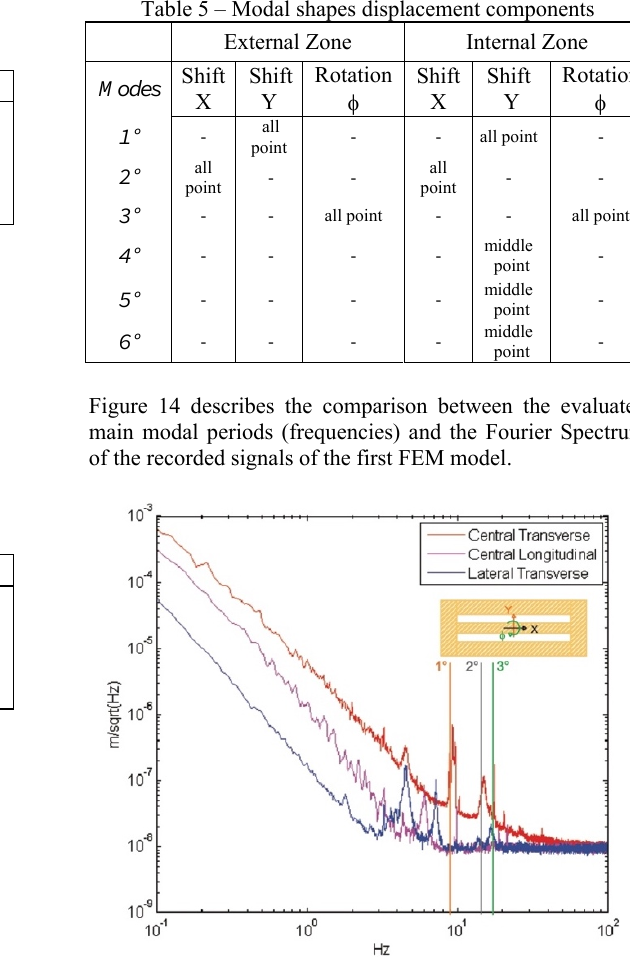
Table 5 describes the activated displacement components in correspondence of the recording stations for each investigated modal shape.